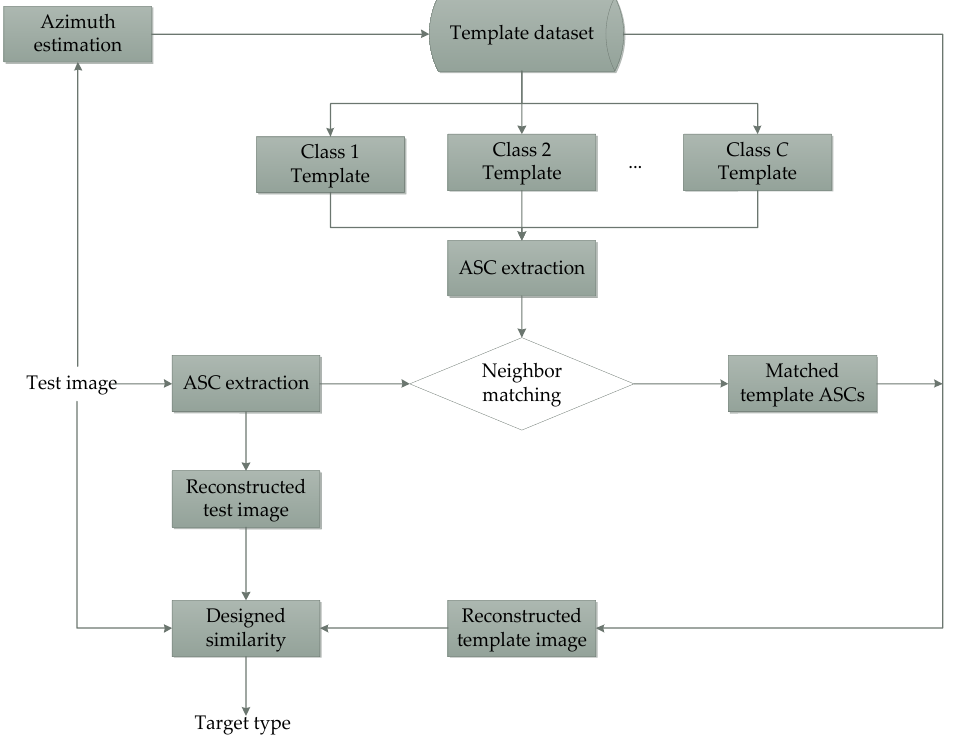
Figure 1. Technical flowchart of the proposed method.